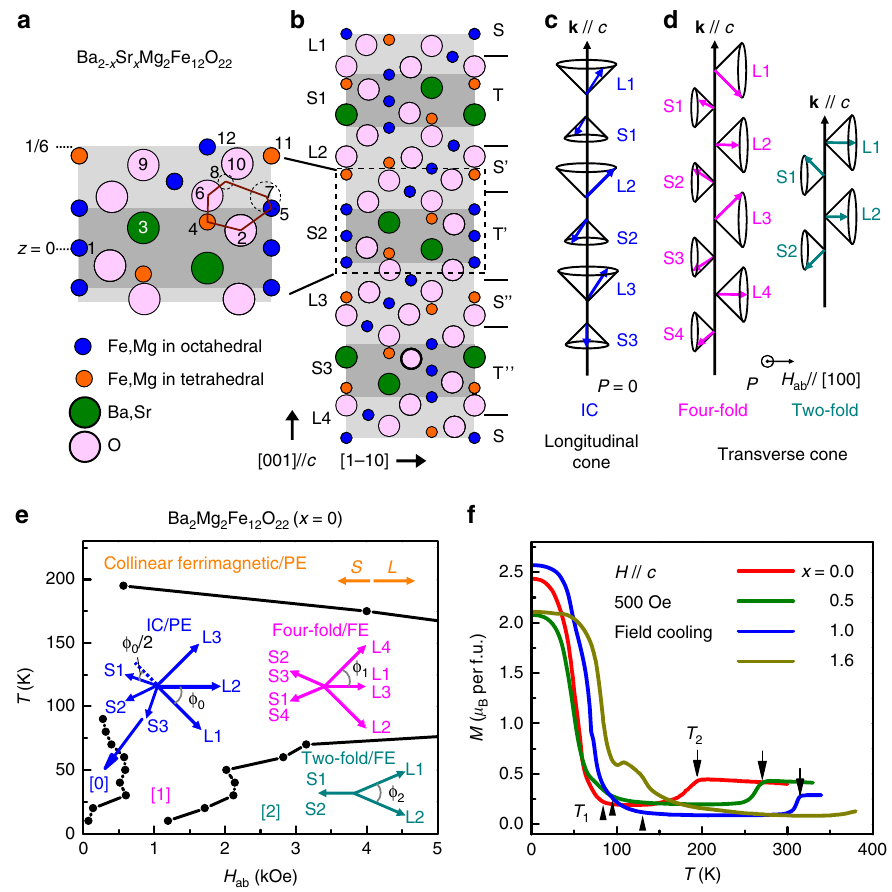
Fig. 1 Structural and magnetic properties of Ba 2- x Sr x MgFe 12 O 22 . a , b Schematic representation of crystal structure of Y-type hexaferrite Ba 2- x Sr x Mg 2 Fe 12 O 22 . The dotted square region is magni fi ed in a . 1 – 12 denote the 12 different atomic layers ranging from z = 0 to 1/6 in one of ( T 1/2 S 1/2 ) structure blocks. The dotted circle 7 and 8 represent the trajectory of those atoms onto the (110) plane since they lie out of the plane. The connected heavy lines indicate the superexchange paths which would be strongly affected by the Sr doping. The structure blocks are alternating stacked along c as STS ’ T ’ S ” T ”— where the apostrophe means the corresponding block is rotated 120° around this axis. The magnetic structure consists of stacks of L blocks and S blocks along c . Illustrations of conical spins (represented by arrows ) with c the incommensurate (IC) longitudinal cone (LC) and d the four-fold and two-fold transverse cone (TC). No polarization exists in IC-LC phase while the in-plane P ( ⊥ H ab ⊥ k ) can be induced in these TC phases. e The magnetic and ME phase diagram of Ba 2 Mg 2 Fe 12 O 22 determined by the measurement of ε - H ab . Below 100 K, it is divided into three areas [0], [1], and [2], corresponding to magnetic structures with IC, four-fold and two-fold periodicities. Above 200 K, a collinear ferrimagnetic structure is stabilized. The ferroelectricity (FE) or paraelectricity (PE) for each phase are marked as well. The insets depict the schematic in-plane magnetic structures in each phase from c and d . ϕ 0 , ϕ 1 and ϕ 2 represent the angles between the in-plane moments of neighboring L blocks in IC, four-fold and two-fold phases, respectively. f Temperature dependence of magnetization measured after fi eld cooling with 500 Oe magnetic fi eld ( H ̸ ̸ c ) of different samples. The black and gray arrows denote the transition temperatures of LC to proper screw ( T 1 ) and proper screw to collinear ferrimagnetic ( T 2 ),